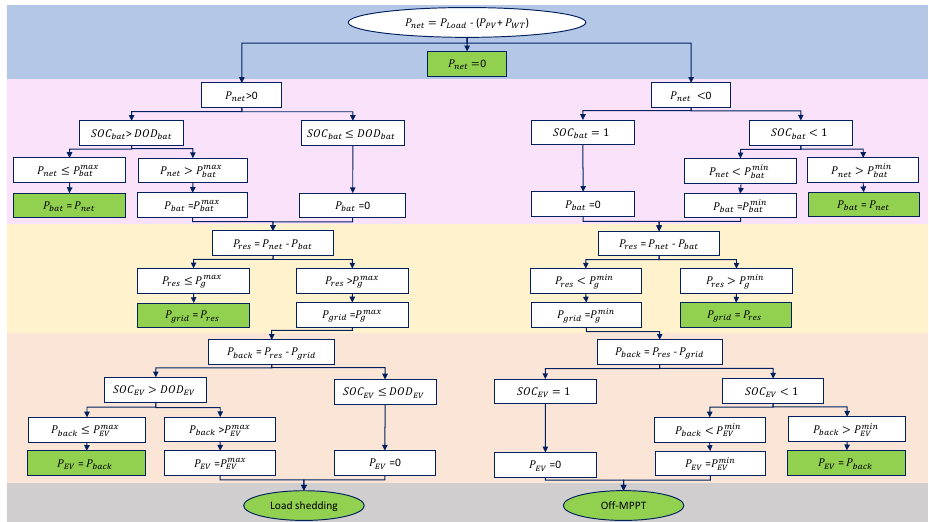
Figure 3. Energy management strategy ( P net is the net power, P res stands for residual power, and P back corresponds to backup